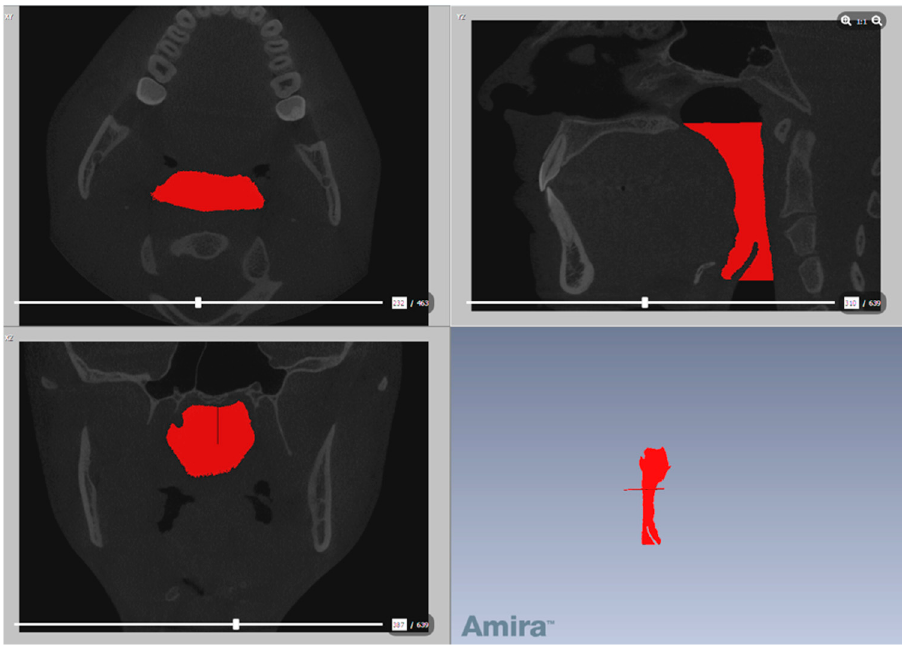
Figure 2. The volumetric measure of upper airways using